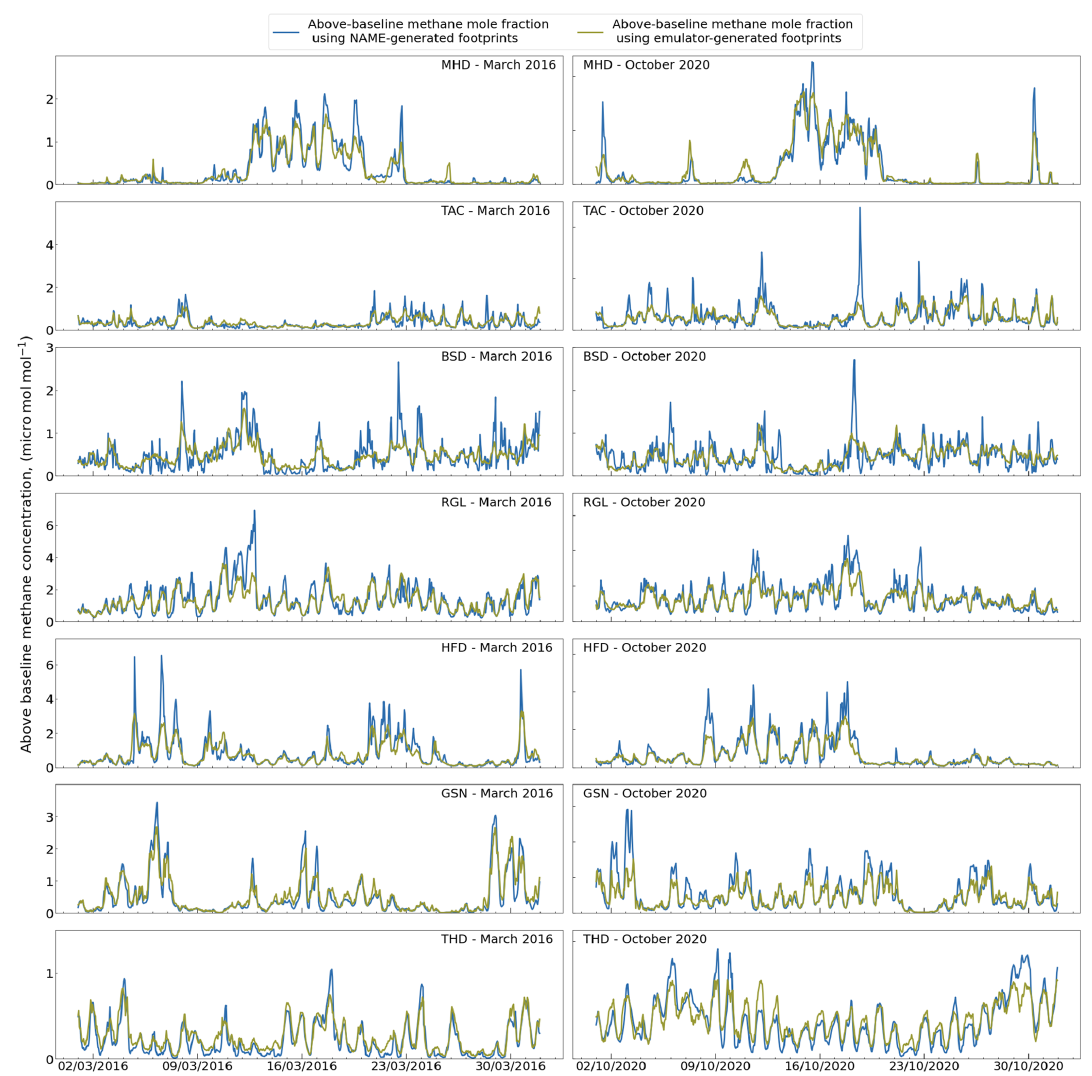
Figure 4. Mole fractions from NAME-generated footprints and predicted footprints for March 2016 (left column) and October 2020 (right column) around each measurement